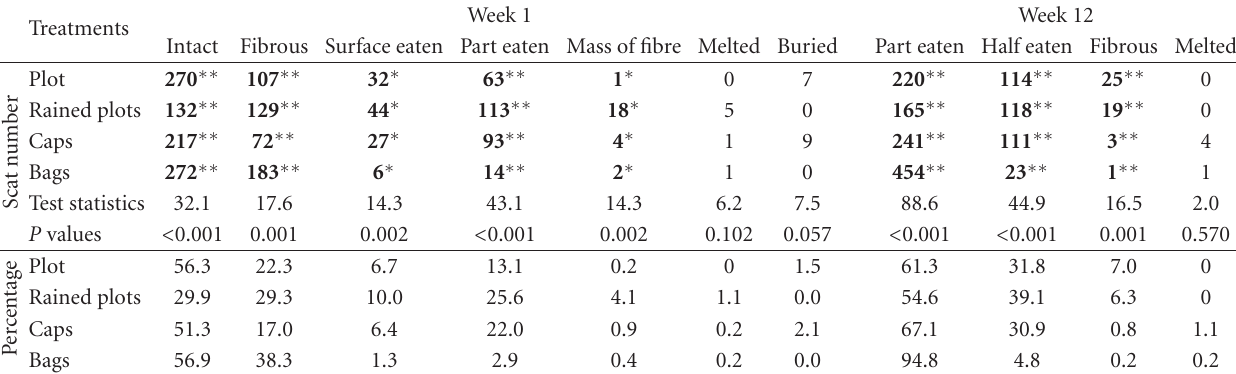
Table 1: Condition of scats at Week 1 and Week 12 in the di ff erent treatments. Treatments